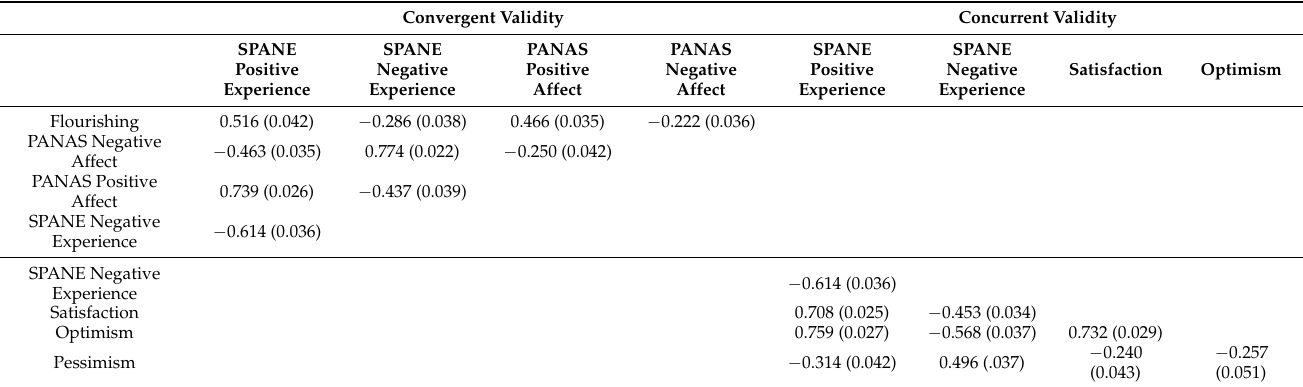
Figure 3. Path diagram for the concurrent validity model. Spane: Scale of Positive and Negative Experience. Table 3. Correlation coefficients (standard errors) between the Scale of Positive and Negative Experience (SPANE) subscales and well-being measures in the validity models.